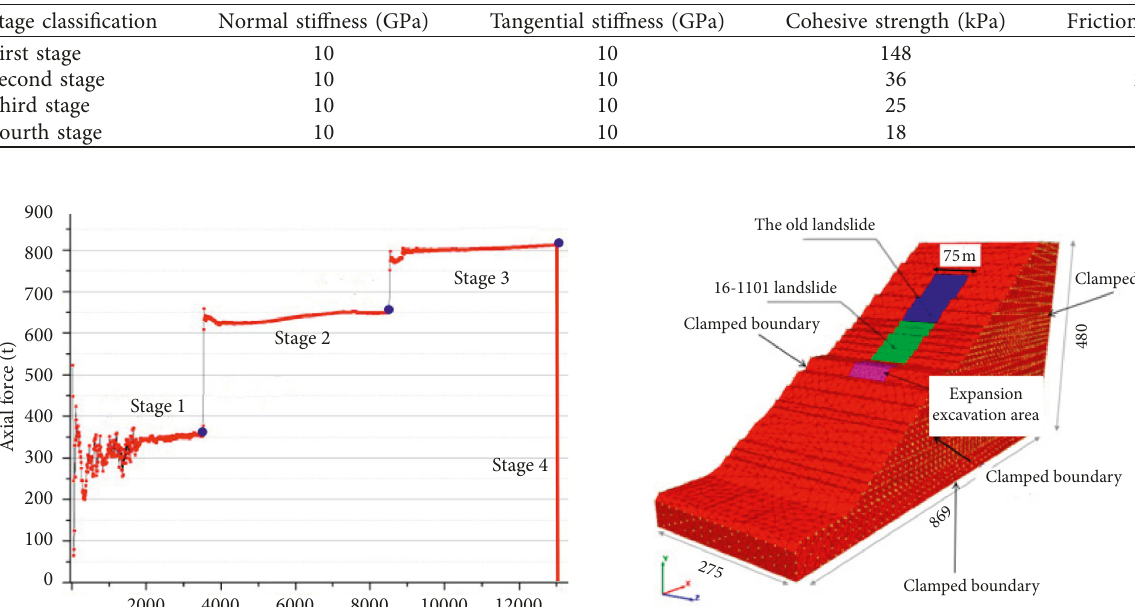
Table 3: Strength degradation stages criteria.